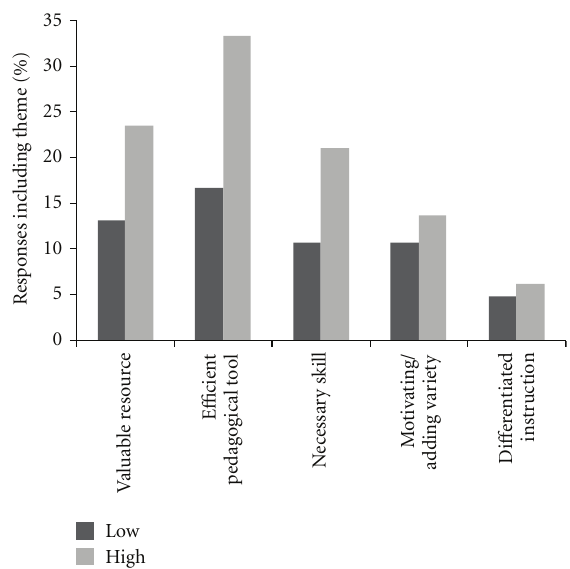
Figure 1: Patterns of themes by integration level for supporting the concept of integrating computer technology for students.